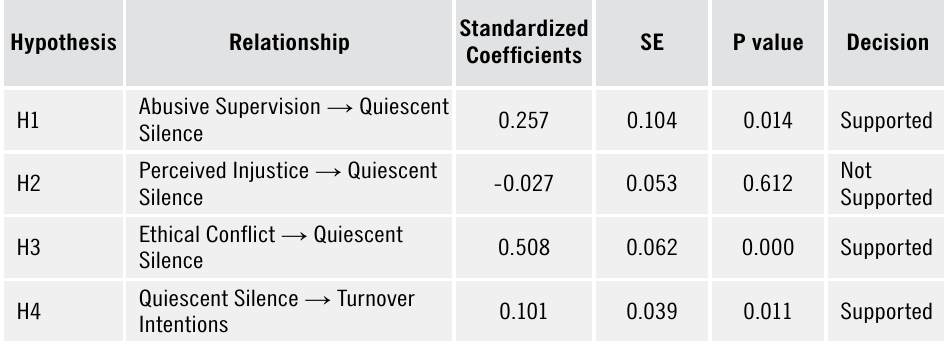
Table 4. Hypotheses testing